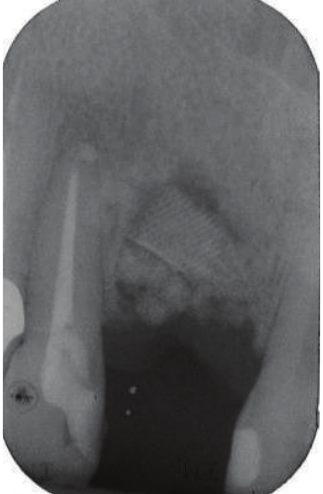
Figure 9: A postoperative periapical radiograph was taken to confirm the filling of the postextraction socket.